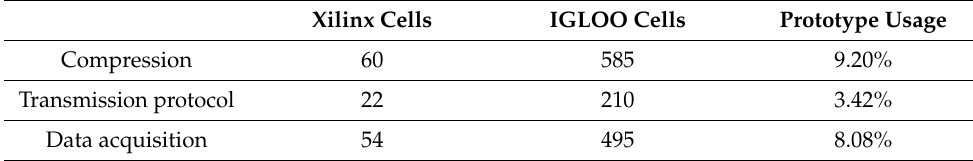
Table 5. Prototype usage percentage measured for the Microsemi AGLN250